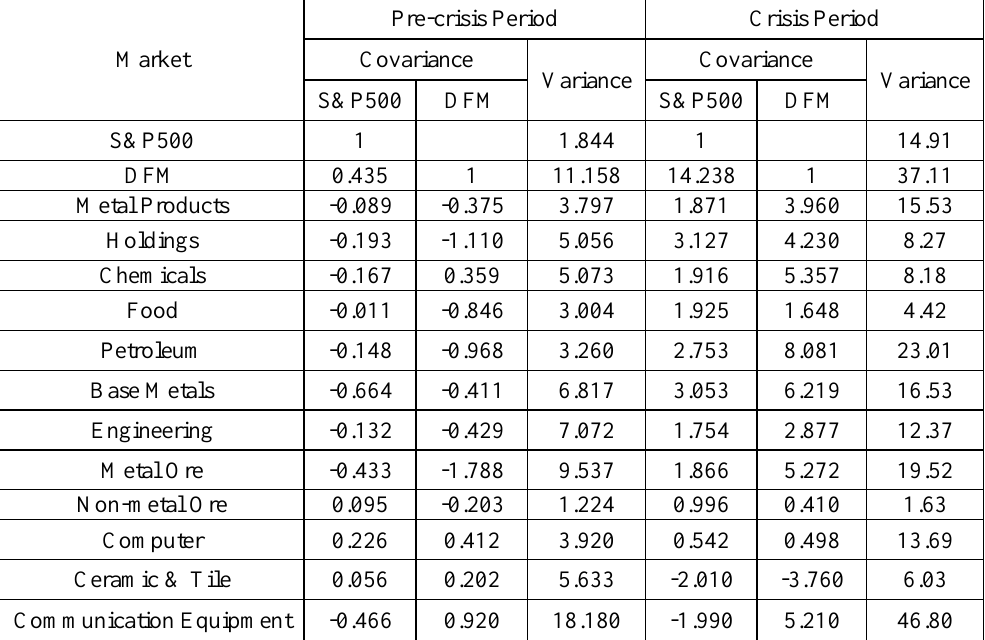
Table5-1 Pre-crisis and Crisis Periods Variance and